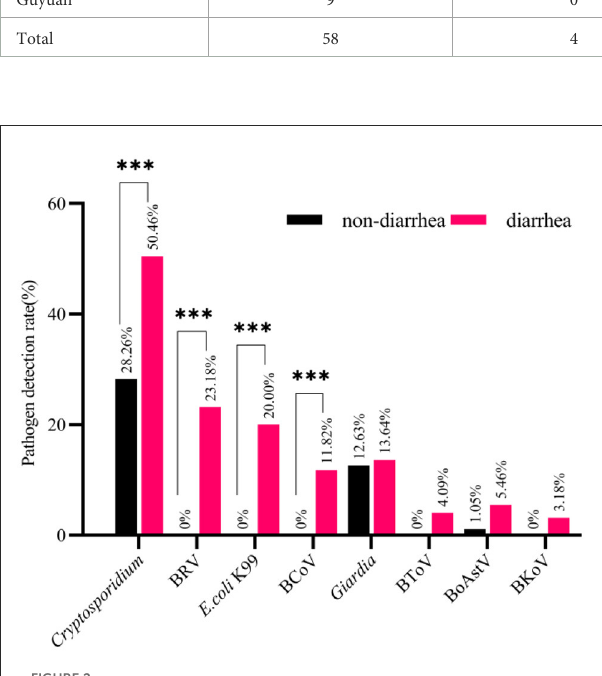
FIGURE2 The Pathogens detection rate of diarrhea samples and the Pathogens detection rate of normal samples. The number of pathogen detection and non-detection in normal stool samples with the number of pathogen detection and non-detection in